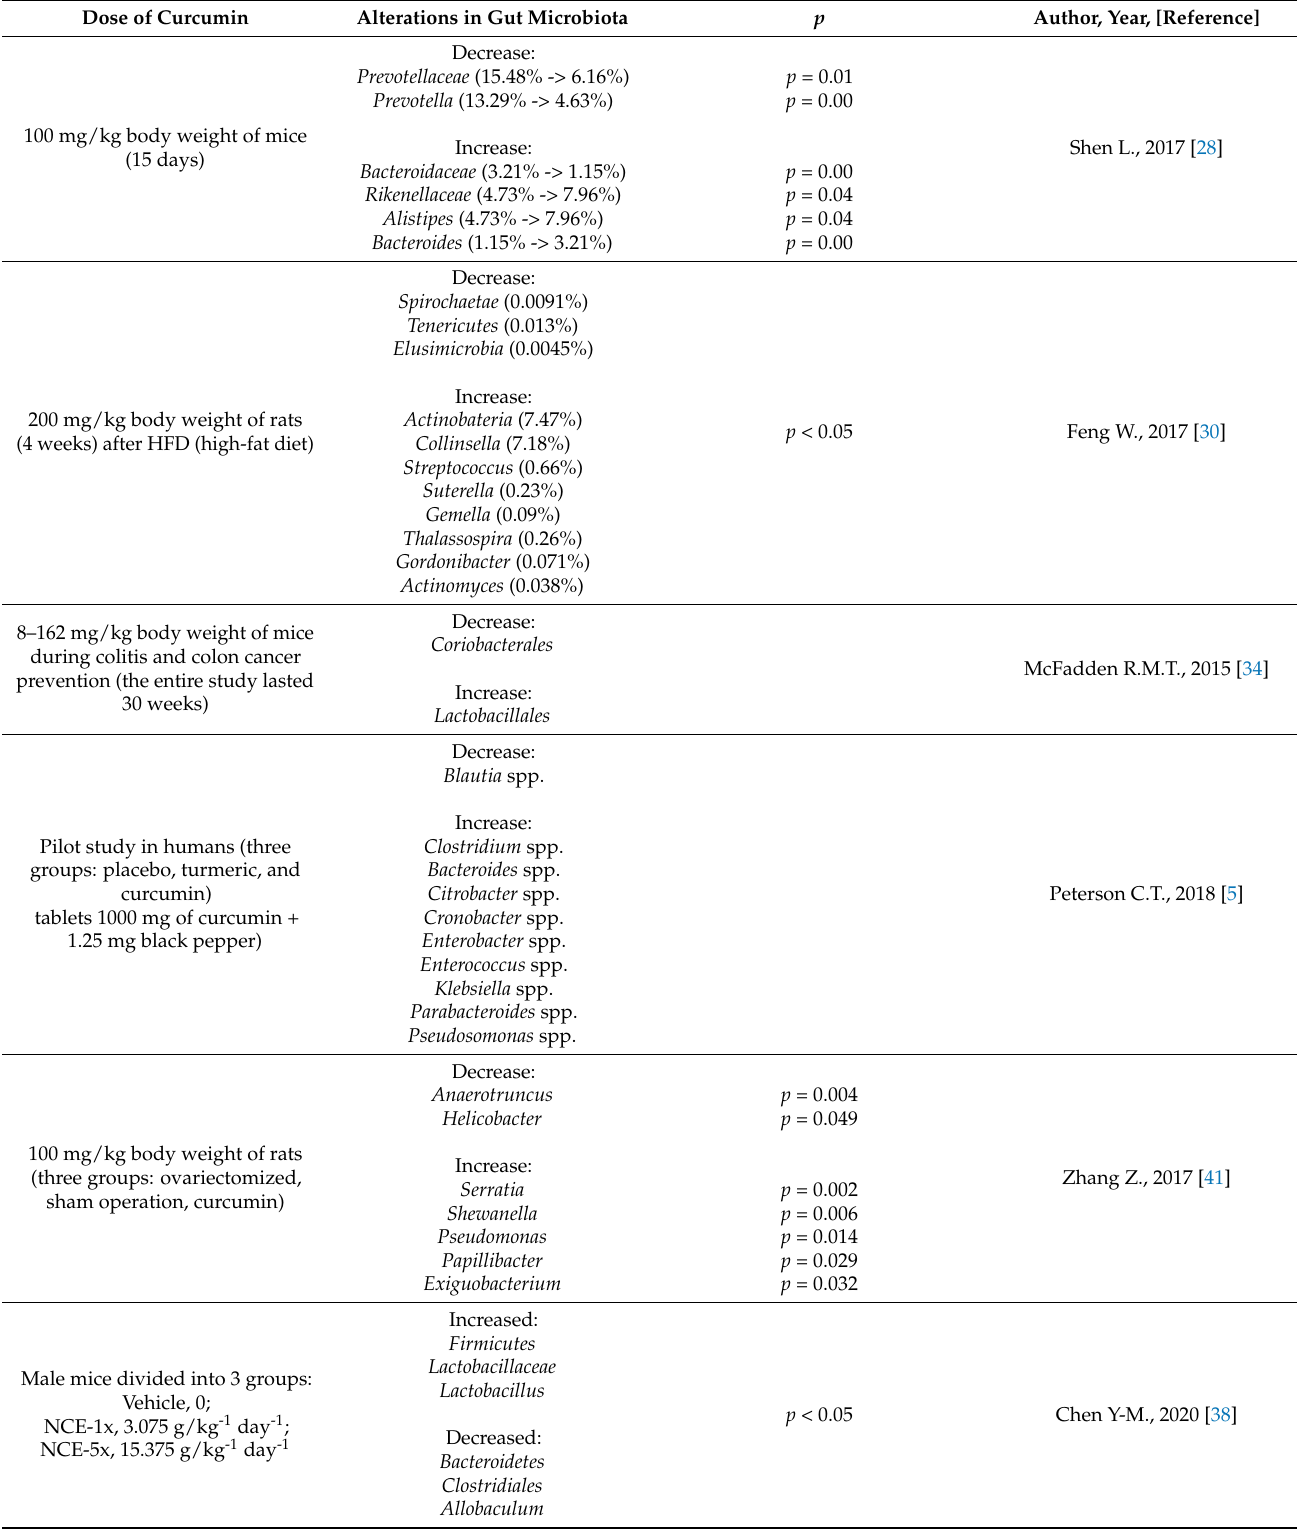
Table 1. Alteration in gut microbiota after curcumin